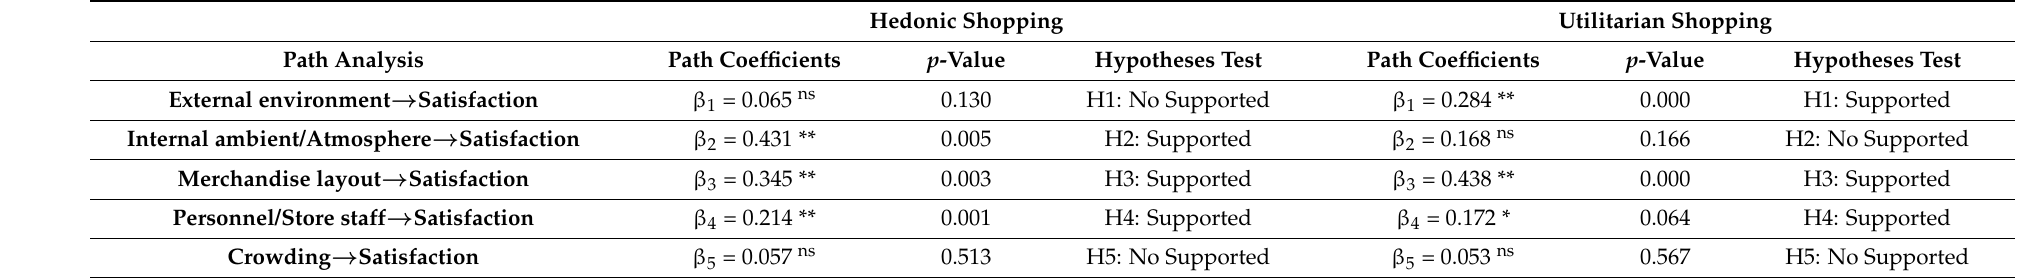
Table 6. Model resolution using PLS algorithm and